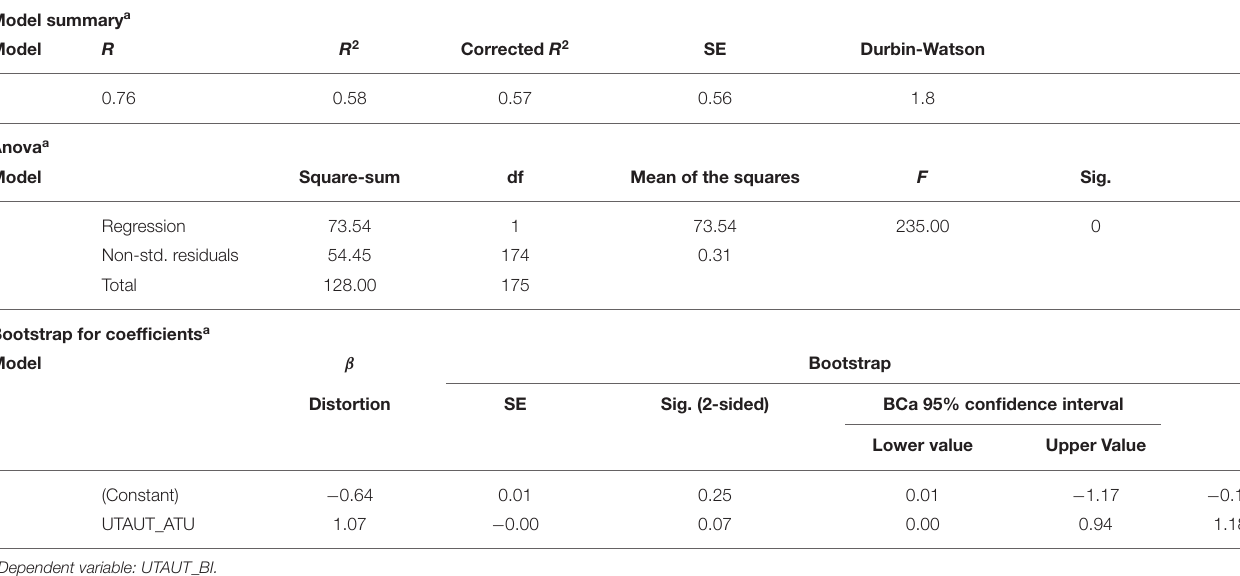
TABLE 6 | Influence of attitude to use on behavioral intention.